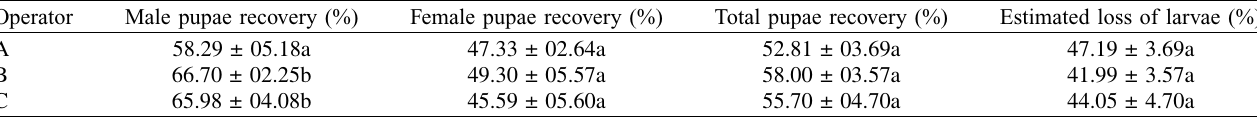
Values were compared to the reference tray position 1 (bottom), individual tray sorting, day 6 and operator A. Values in bold indicate a statistically signi fi cant difference ( p < 0.05). Table 4. Estimated male, female, and total pupae recovery rates and loss of larvae between operators.